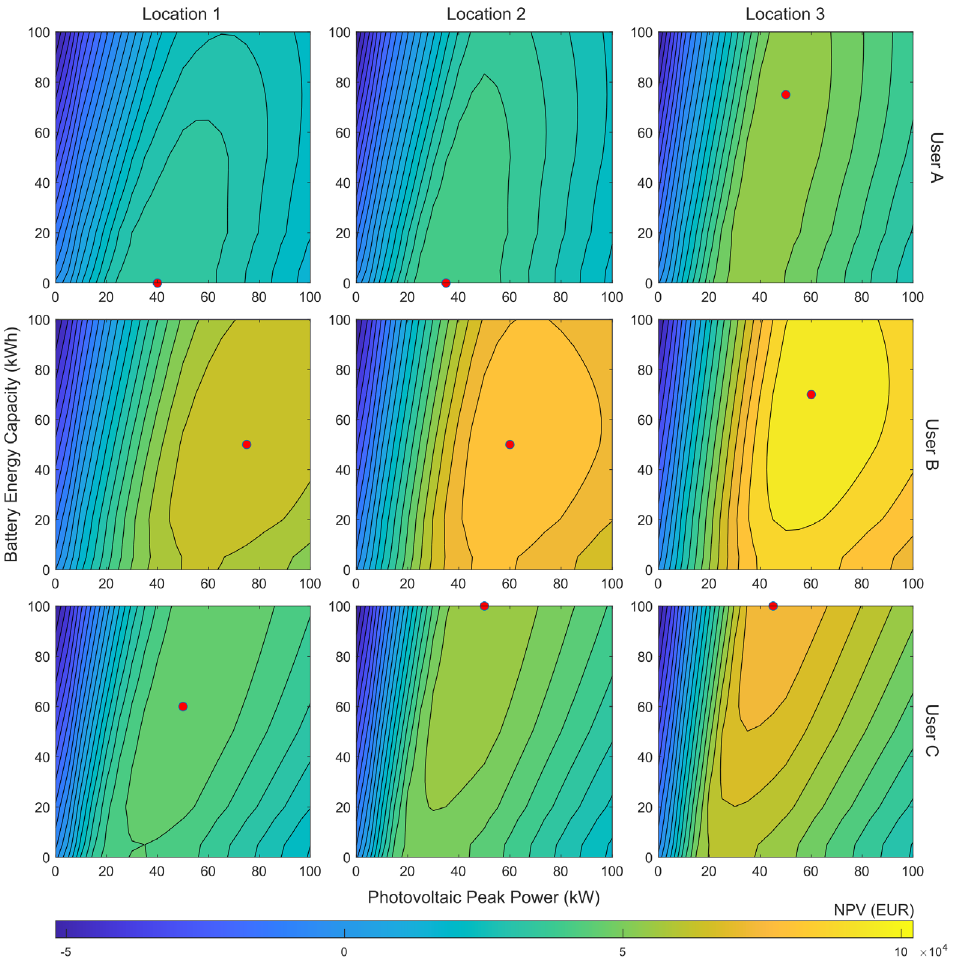
Figure 5. NPV for different combinations of battery capacity and PV power for the users and locations analyzed using self-consumption model 1 and 0% BESS price reduction. The red dots indicate the optimal solution for each scenario.